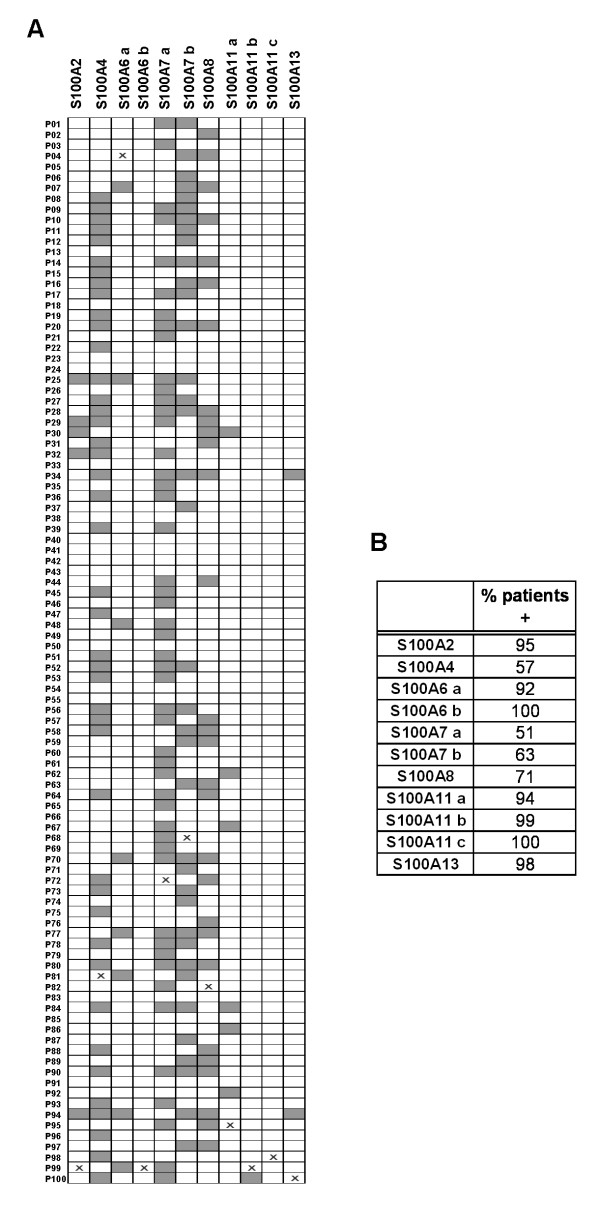
Qualitative analysis of the eleven S100 protein forms among the 100 patients. (A) Diagram illustrating the occurrence of the identified S100 protein members (abscissa) among the patients indicated from P01 to P100 (ordinate). The gray boxes indicate absence of proteins in the map of the corresponding patient; the crosses in the white boxes indicate the patients expressing the given protein at its highest level among the others. (B) Table reporting the percentage of the enrolled patients expressing the different S100 protein forms.